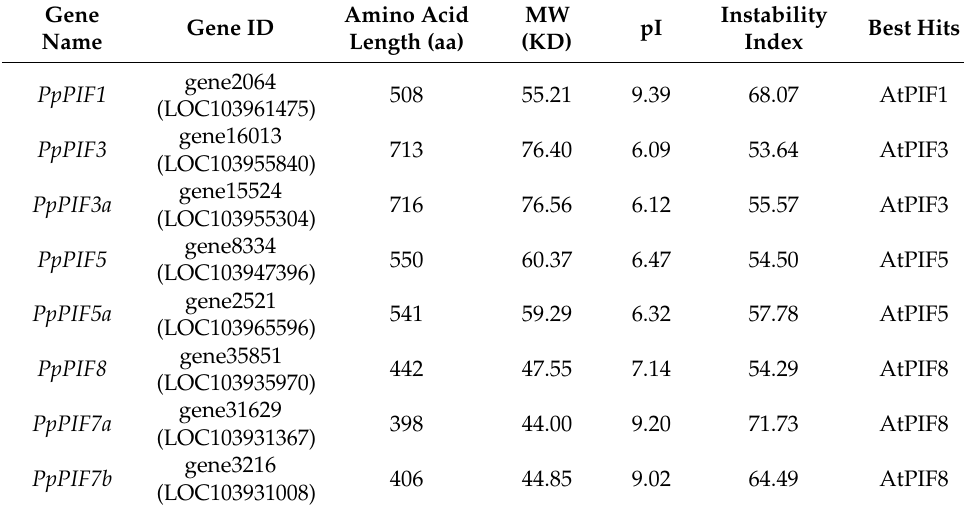
Table 2. Characteristics of phytochrome-interacting factors (PIFs) genes in pear.